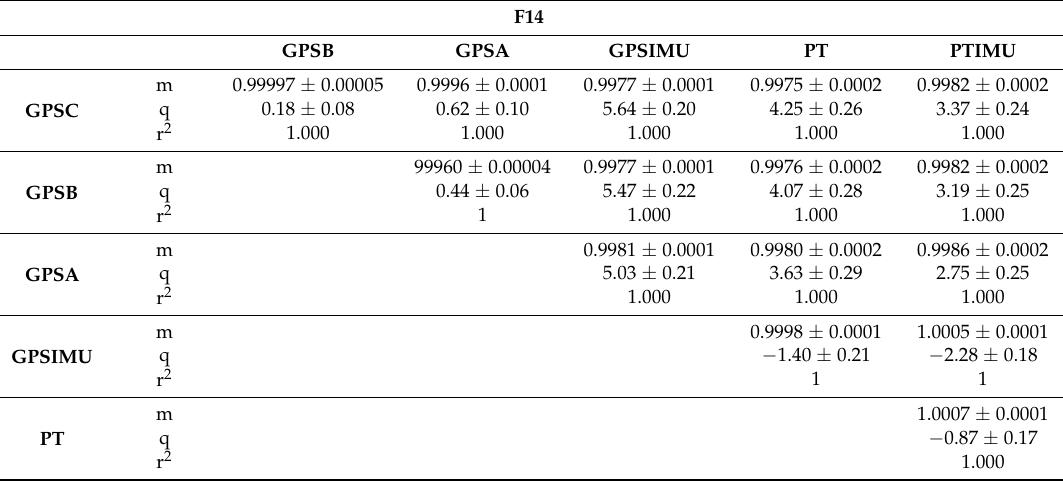
Table A5. Linear regression data of F14 (DATASET2 β